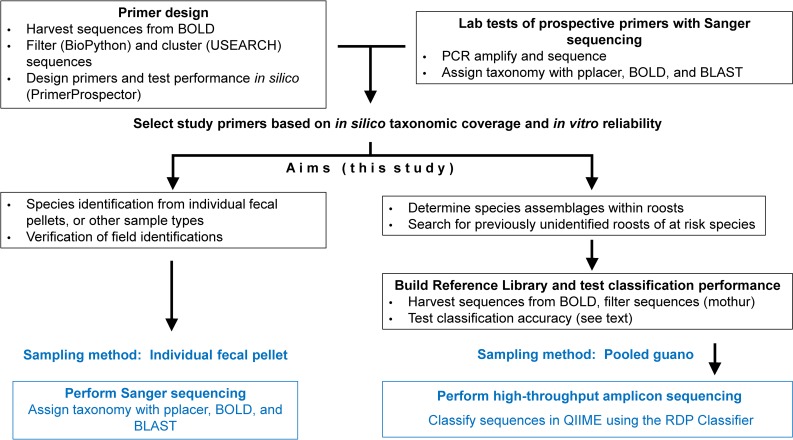
Pathway for Species from Feces assay development.After development, the assay can be applied by following the protocols in blue.